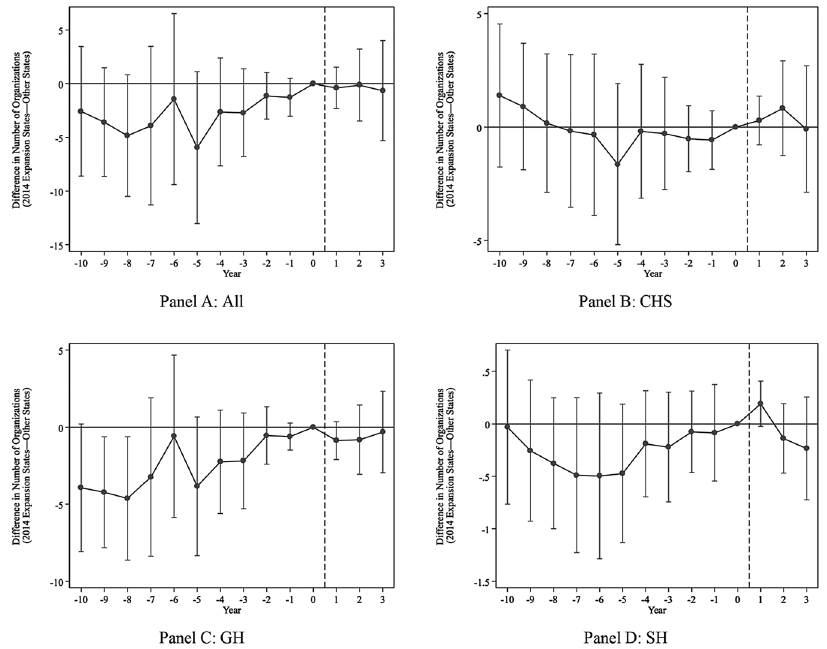
Figure1: Differencesinthenumberofnonprofithospitalsbetweentheexpansionstatesandthe non-expansion